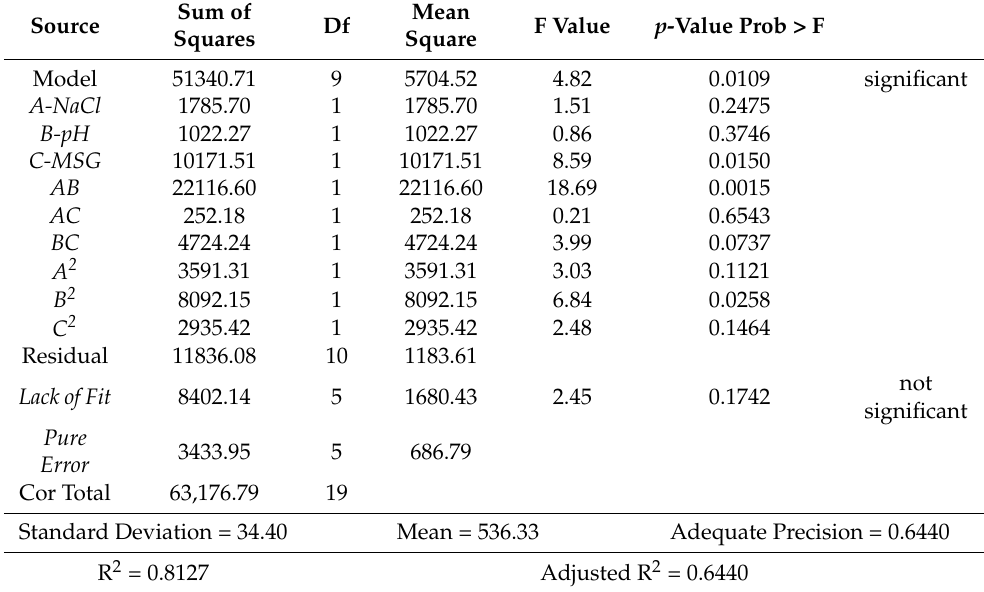
Table 3. Analysis of variance (ANOVA) from obtained results of GABA production by T. halophilus strain